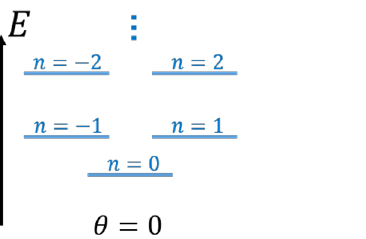
(cid:0) (cid:1) 2 n (cid:0) (cid:18) for n 2 Z . Starting 2 2 (cid:25)